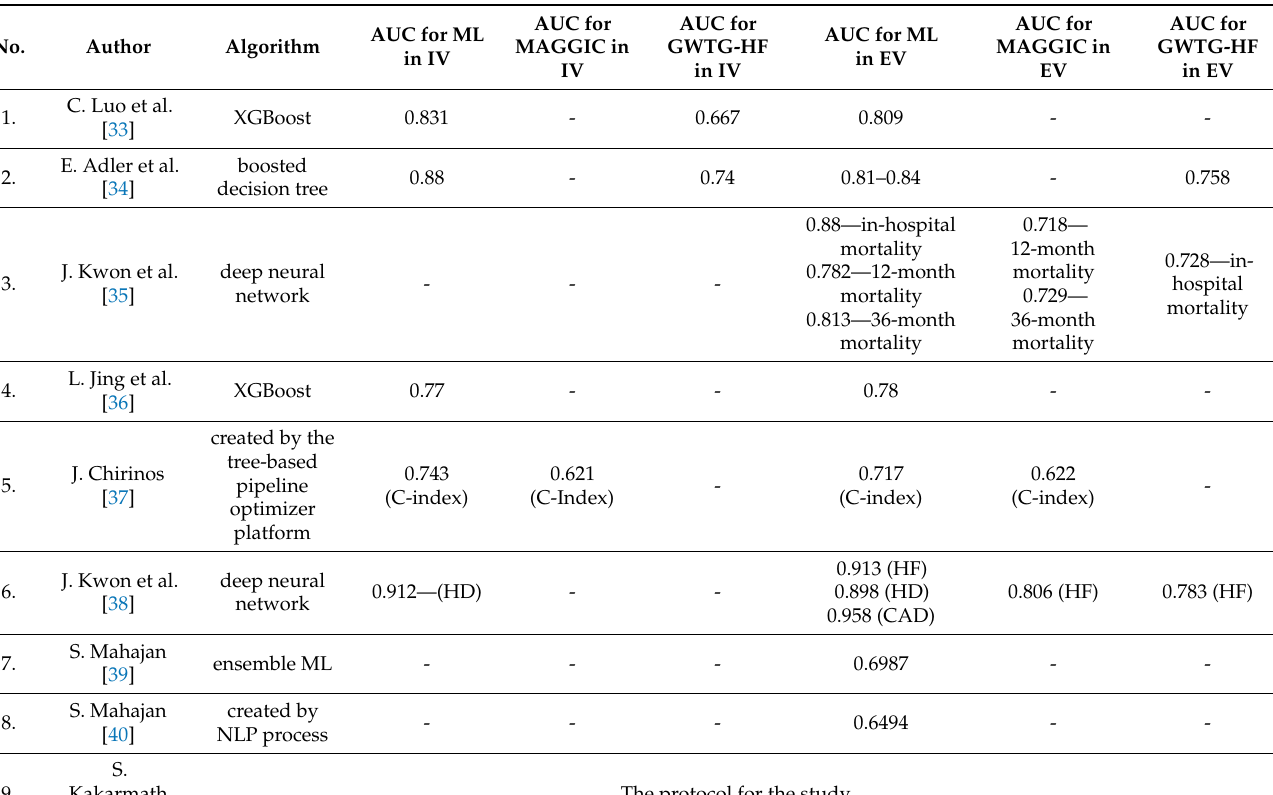
Table 3. Performance metrics for machine learning algorithms and conventional risk scores. IV— internal validation, EV—external validation, ML—machine learning, NLP—natural language process- ing, HF—heart failure, HFrEF—heart failure with reduced ejection fraction, HFmrEF—heart failure with mid-range ejection fraction, HFpEF—heart failure with preserved ejection fraction HD—heart disease, CAD—coronary artery